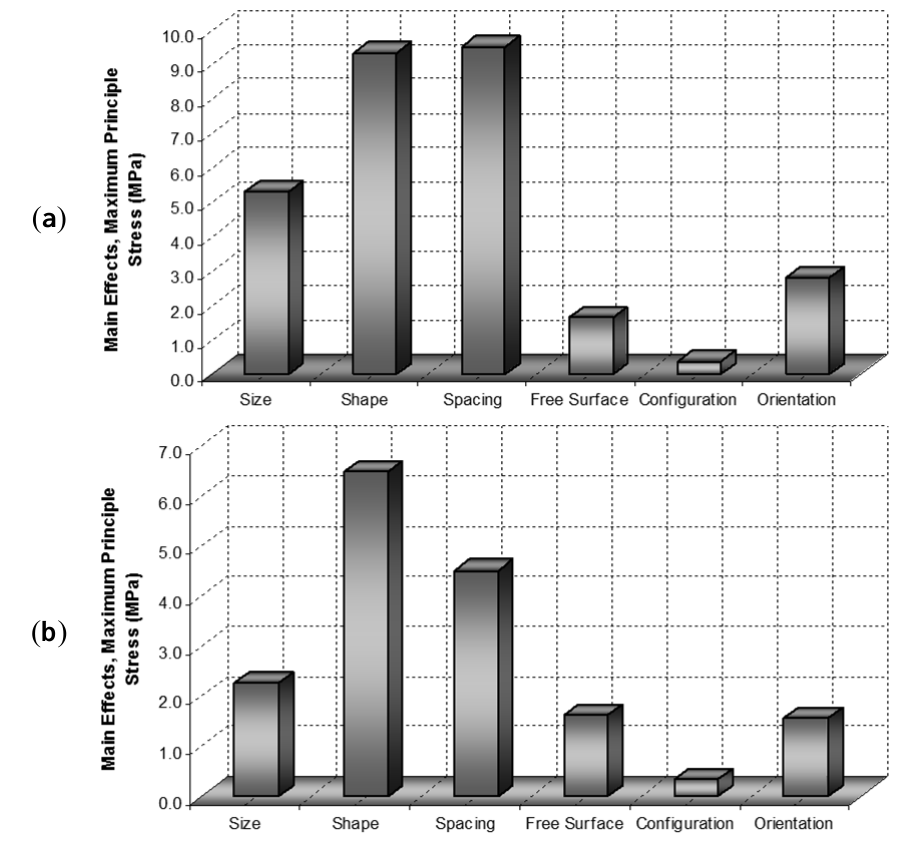
Figure 27. The influence of casting parameters on ( a ) Maximum principal